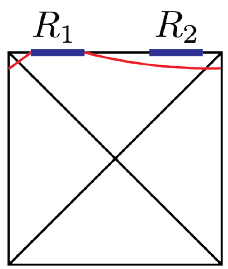
Figure 5. We imagine taking global de Sitter and freezing two regions near I + pictured in red. We integrate over the geometry away from these intervals. Naively, there is a puzzle since the entanglement wedge for one of the intervals appears to encompass the whole universe, since the spatial cross sections are compact. The naive entanglement wedge for R 2 is pictured in